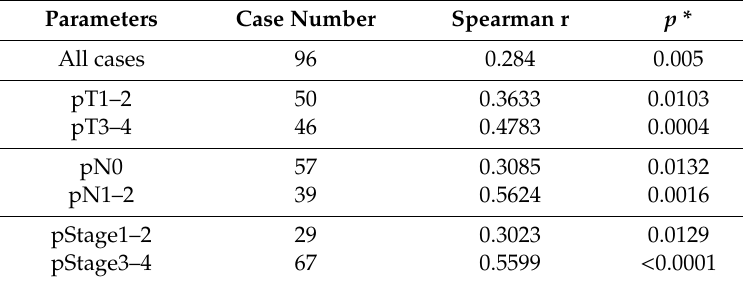
Table 2. Correlation between ME1 expression and tumor budding.